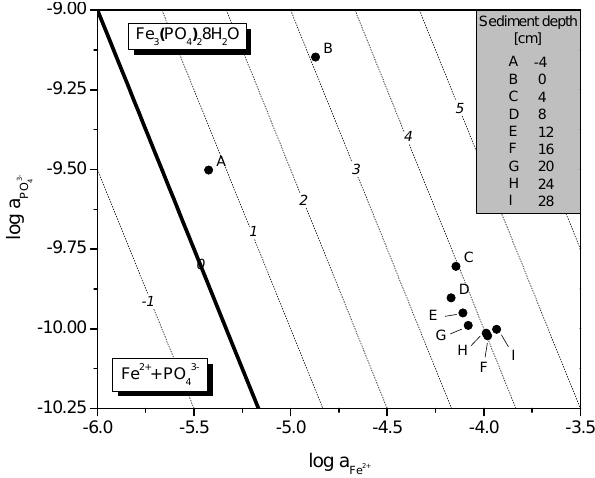
Figure 2. Degree of saturation of the pore water with respect to vi- vianite of Lake Groß-Glienicke in nine different sediment depths (A–I) (September 2013). Letters next to data points indicate sam- pling depth (positive downward sampling depth). The thick line in the diagram represents the vivianite solubility constant K viv = 1 × 10 − 36 given by Nriagu